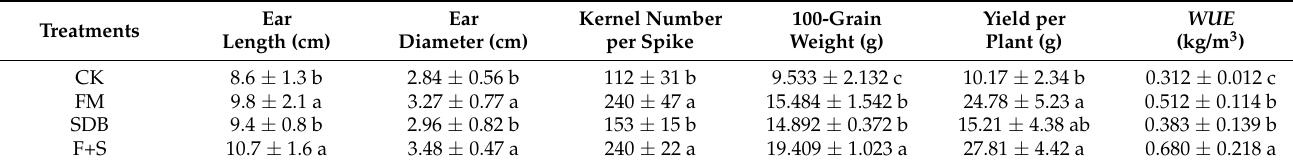
Table 8. The yield and its constituent factors